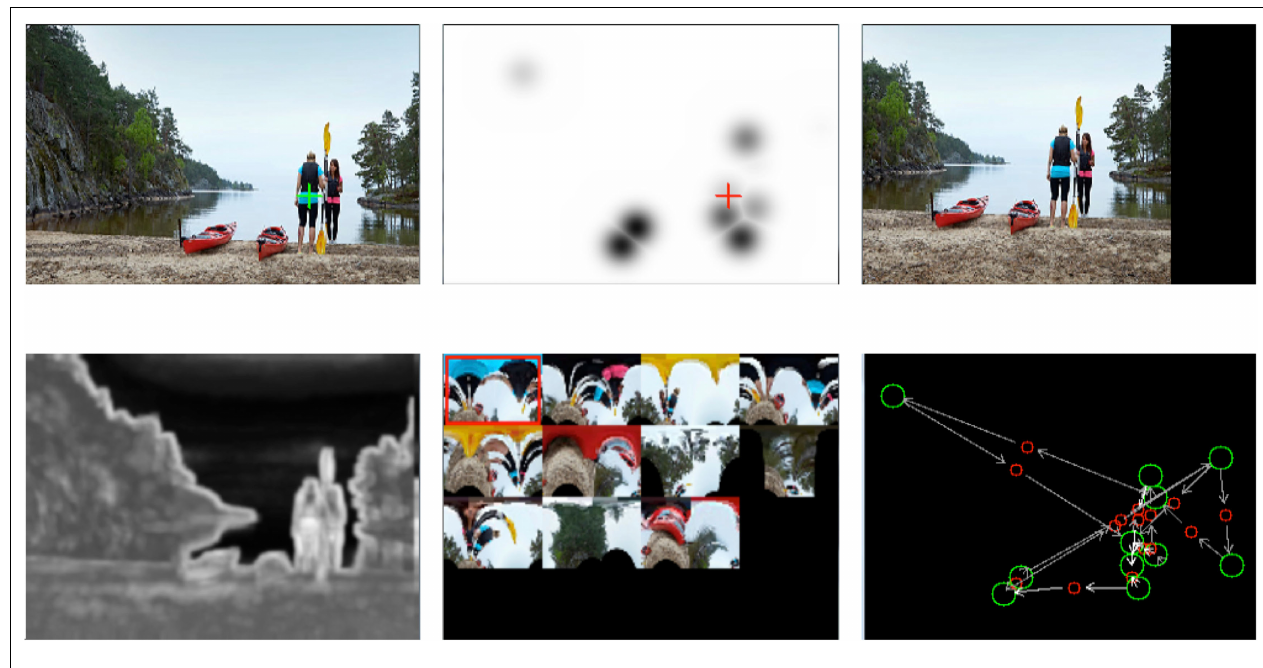
by the red rectangle and the blue shirt is clearly visible in the fovea; (top right) the input image shifts to place the fixation point at the center; (bottom right) a graphic visualization of the joint episodic-procedural memory, with fixation-point episodes rendered as green circles, saccade actions rendered as red circles, and graph connections as directed arrows . Note that this graph is not registered with the image since the actions are specified in gaze angles, not image